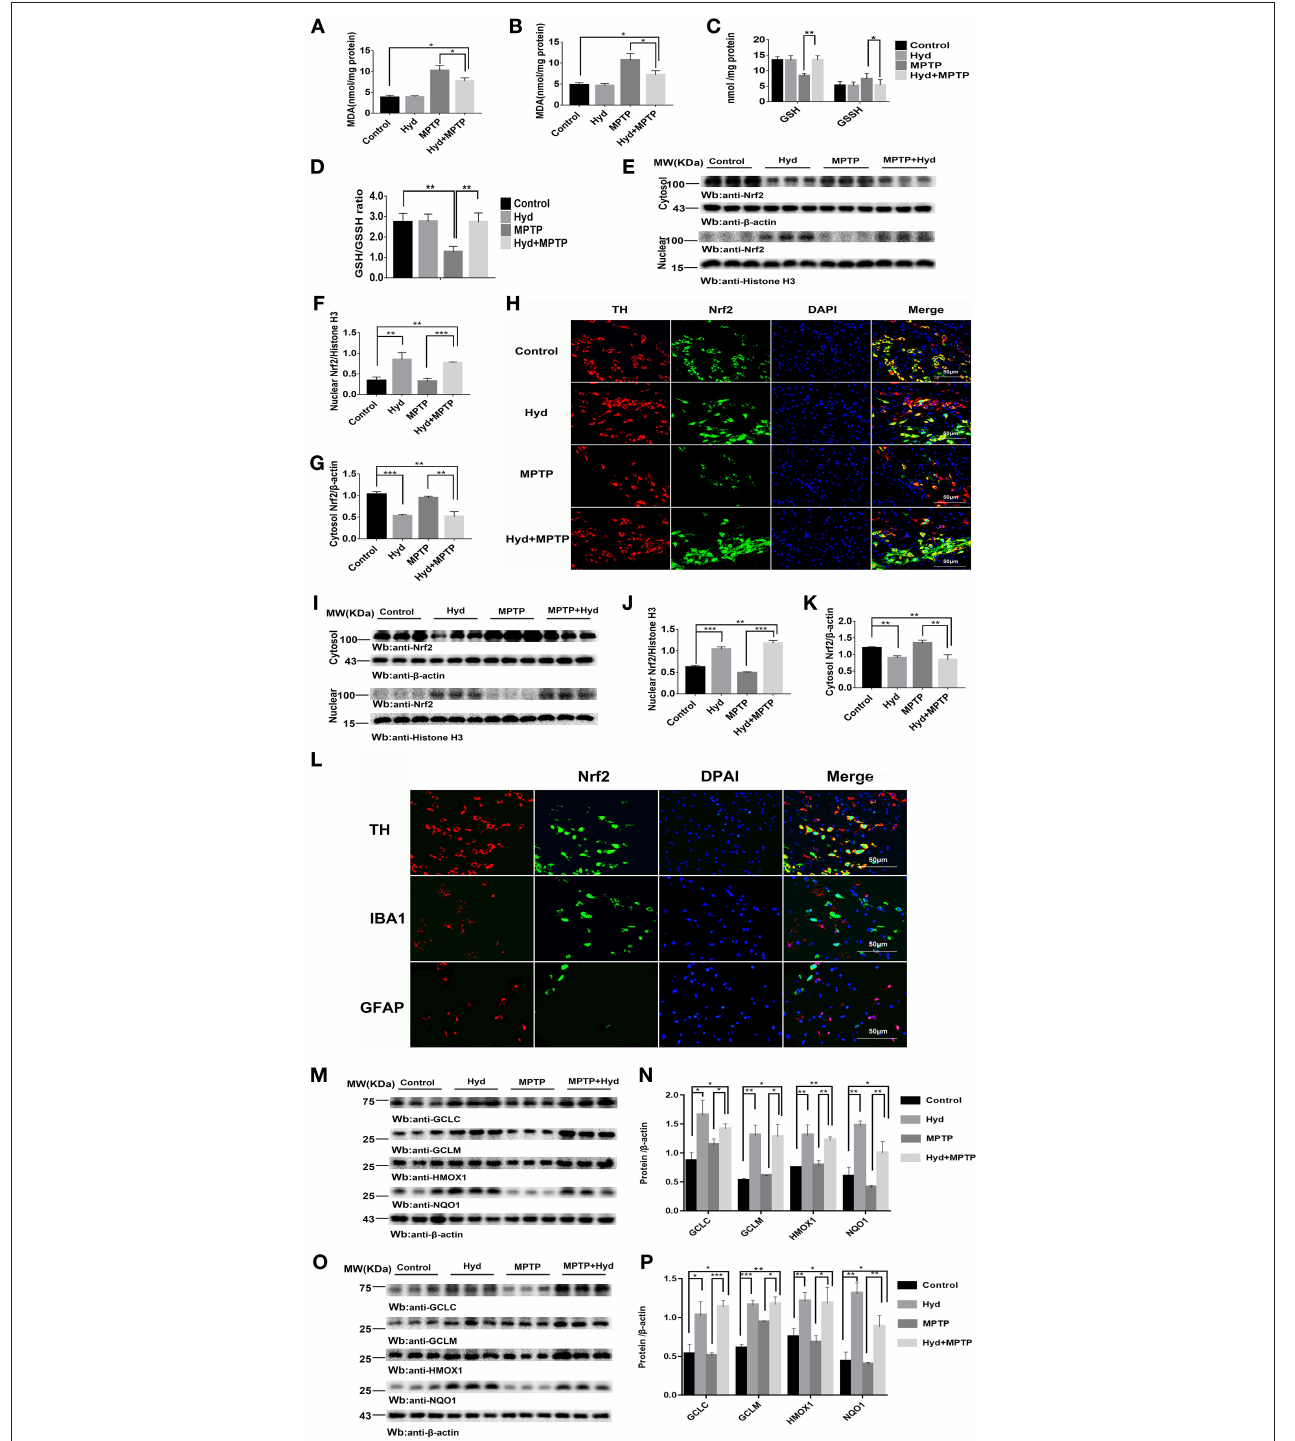
FIGURE 4 | Hydralazine alleviate oxidative stress and activates Nrf2-triggered gene expression in vivo. Hydralazine significantly decreased MDA in the substantia nigra (A) and striatum(B) of MPTP mice treated with hydralazine compared with MPTP mice. * p < 0.05, n = 5, significant difference between the two indicated groups. MPTP administration showed a remarkable decrease in GSH levels and increase in GSSH that was inhibited by hydralazine in the SNpc, corresponding increase in the ratio of GSH/GSSG (C,D) . * p < 0.05, ** p < 0.01, n = 5, significant difference between the two indicated groups. Hydralazine treatment leads to a shift in Nrf2 migration and increases nuclear Nrf2 Protein levels, in the meantime, cytosolic Nrf2 had corresponding decrease in the substantia nigra (E–H) and striatum (I–K) of